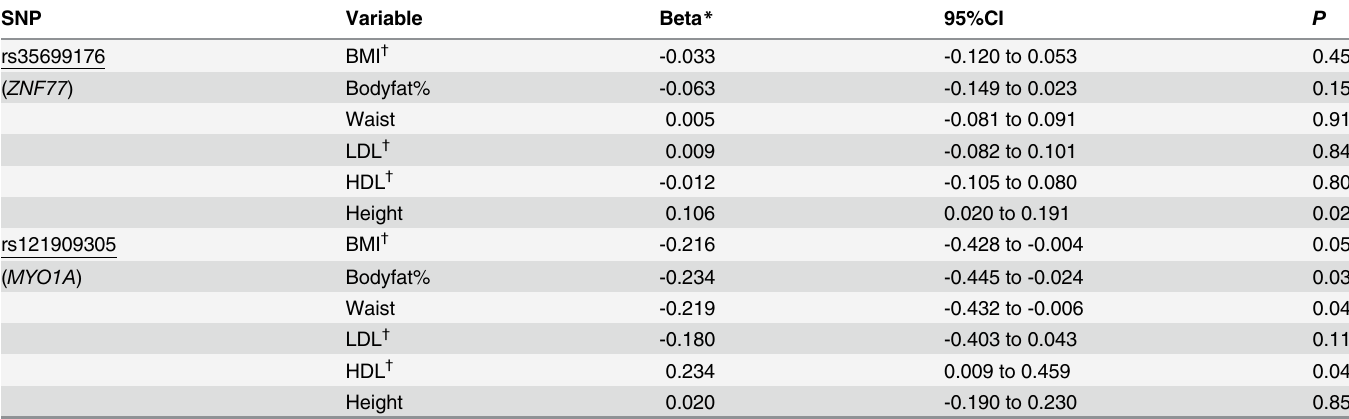
Table 4. Linear regression models adjusted for sex and age exploring the relation between various GH-associated variables and the stop codon mutations.